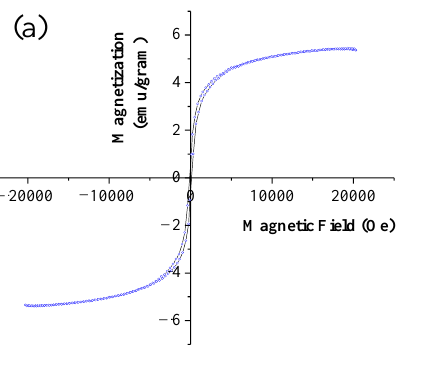
Figure 6. VSM of the α -mangosteen-loaded PF127-Chi@MRGO nanocomposites ( a ); the nanocom- posites under magnetic field exposure ( b ).